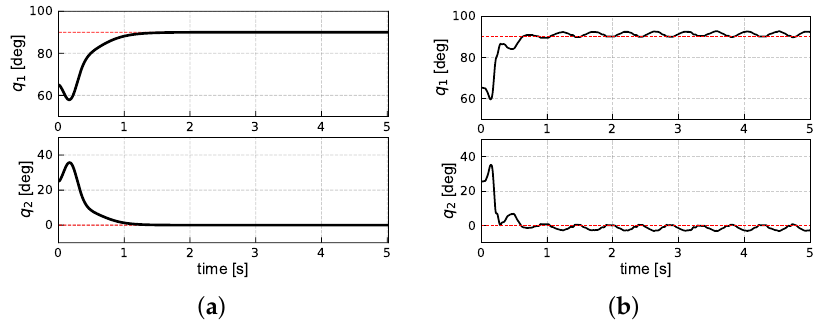
Figure 5. Case A1: Angular positions: ( a ) simulation, ( b ) experiment.